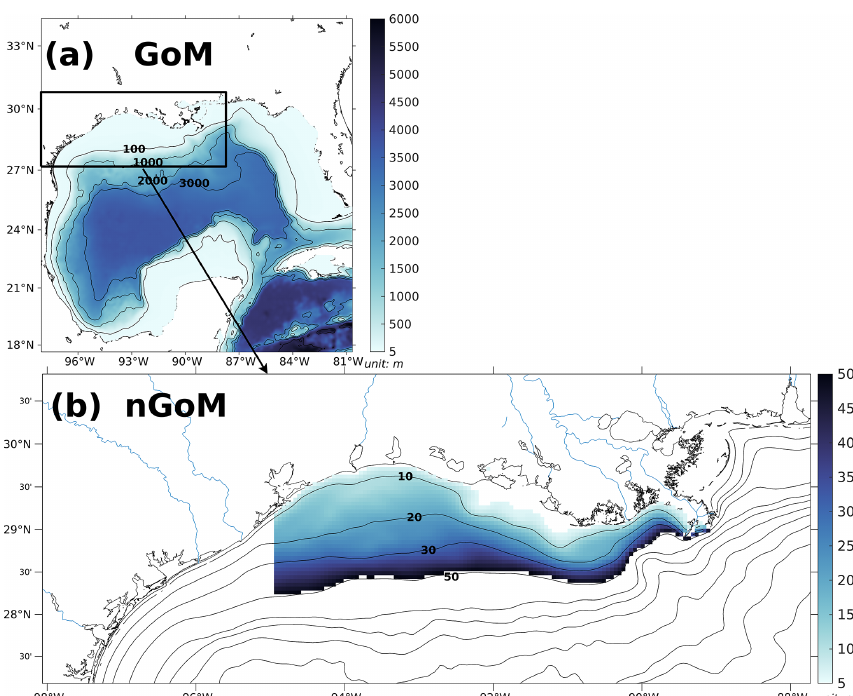
Figure A1. (a) Bathymetry of the entire domain of the Gulf–COAWST described in the accompanying study (Part 1) and (b) zoom-in bathymetry plot of the northern Gulf of Mexico (nGoM). The range of bathymetry of the color shaded area in (b) is from 6 to 50m, over which the regional averages of parameters are conducted.